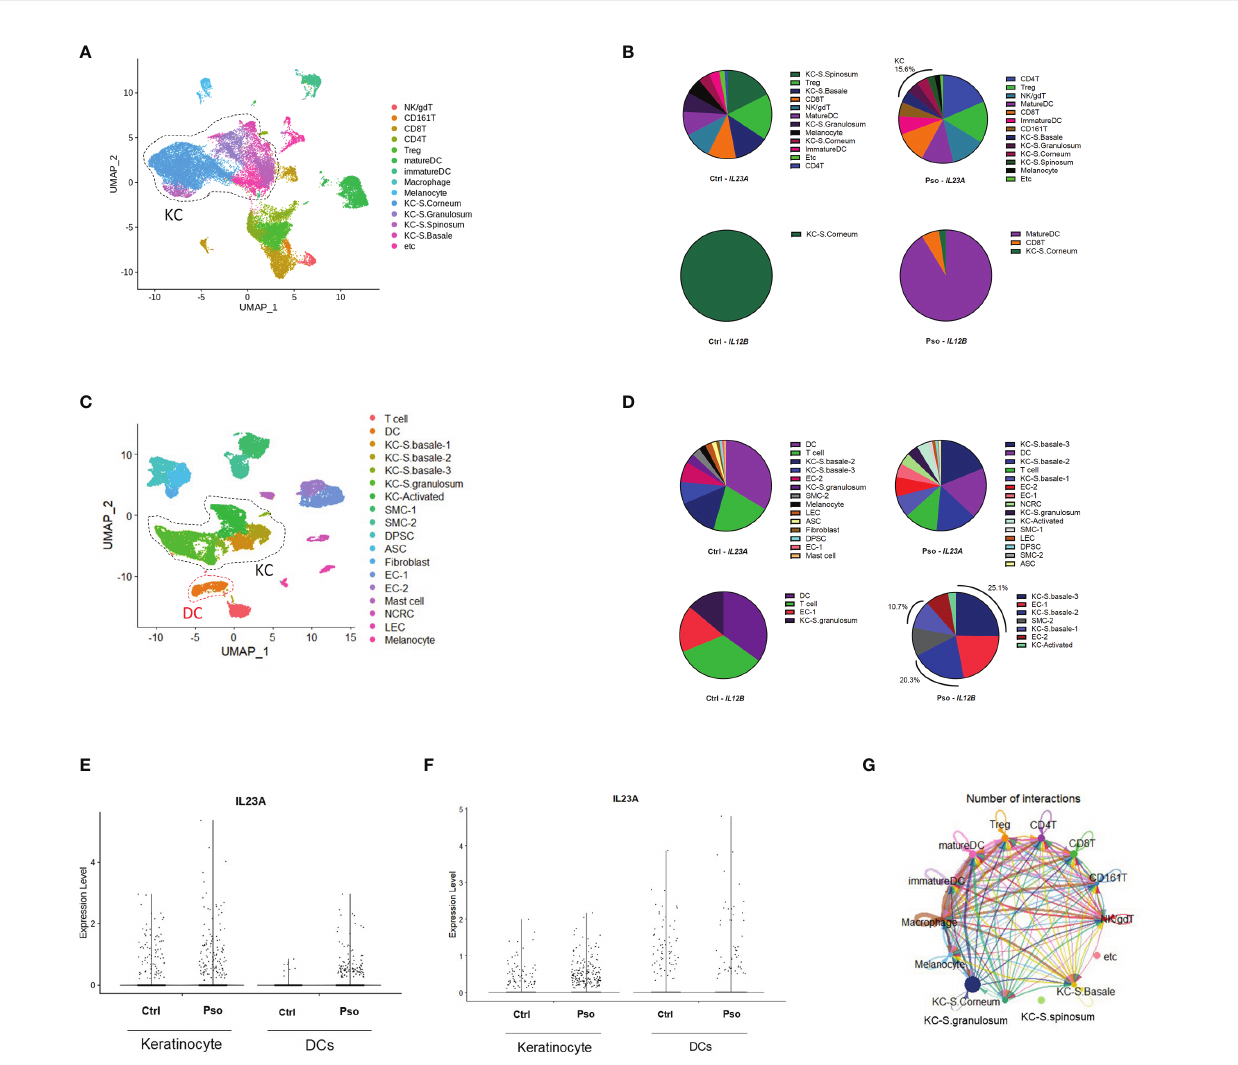
FIGURE 1 | Keratinocyte-derived IL23A expression in the GSE151177 and GSE162183 datasets. (A) Uniform Manifold Approximation and Projection (UMAP) of the single-cell RNA sequencing (scRNA-seq) data from GSE151177. (B) Percentage of each IL23A-expressing cluster in GSE151177. (C) UMAP of the scRNA-seq data from GSE162183. (D) Percentage of each IL23A-expressing cluster in GSE62183. (E, F) IL23A expression levels in the DCs and keratinocytes of GSE151177 (E) and GSE162183 (F) . (G) CellChat network showing the number of interactions between clusters in